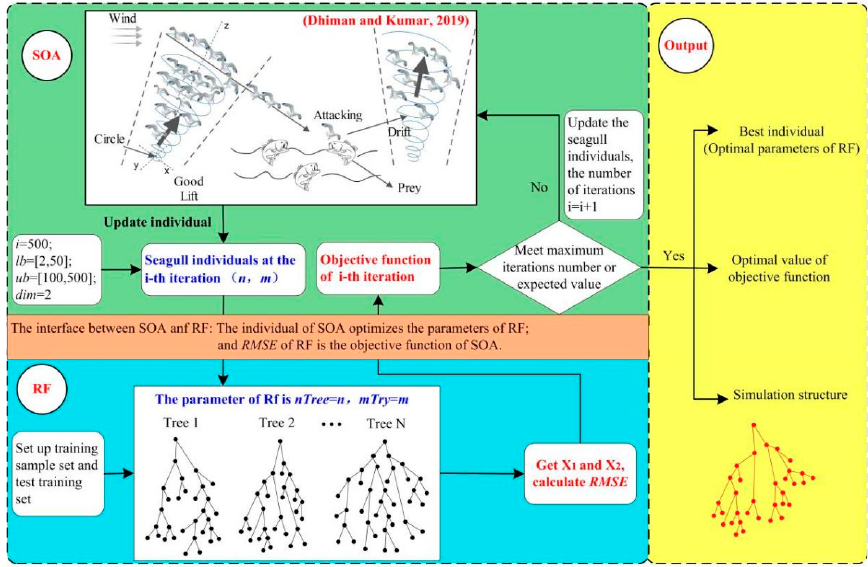
Figure 2. SOA-RF model process [16,19].